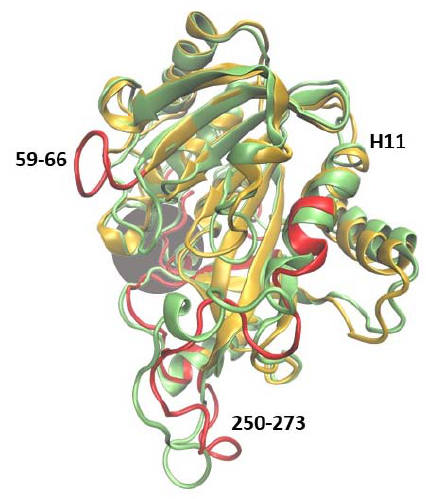
Figure 7. Superposition of two trajectory-derived structures, 6Ala1 PNP (yellow, captured at 150 ns) and one subunit of the WT3 PNP (green, at 150 ns). The gray area marks the approximate location of the active site. The largest displacements observed in the 6Ala1 PNP are marked red and, in principle, are similar to those observed in the case of WT1 PNP (compare with Figure 4), but in the mutant, additionally, the region 250–273 exhibits more flexibility than in the WT1 PNP and WT3 PNP. Additionally, in the 6Ala1 PNP, the active site changes its shape (Figure 8), as already observed for the WT1 PNP (compare with Figure 5). Here, also, the residues His64, Tyr88, Glu89, Phe200, and Glu201 change their positions—the loop on which His64 is placed moves away from the active site pocket, Glu201 is directed away from the active site because of the burying of Phe200, and the helix on which residues 88–89 are placed fluctuates a lot. Moreover, in the 6Ala1 mutant, an increase of the RMSF of His257 and (in one replicate) Glu259 are observed, as well. The His257 of the 6Ala1 PNP is moved outside of the active site, as the helix on which it is placed unwinds in one of the replicates of the 6Ala1 simulations. However, in another replicate, the helix on which His257 and Glu259 are placed moves away from the binding site in its entirety, likely as a result of the overall destabilization of the structure.